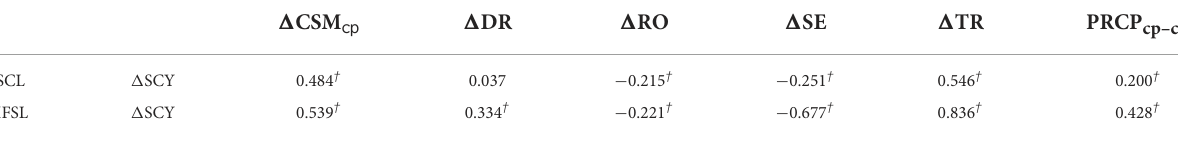
TABLE 3 Pearson correlations of PSCL and MFSL seed cotton yield effects ( 1 SCY) vs. column soil moisture effects at planting ( 1 CSM cp ), drainage ( 1 DR), runoff ( 1 RO), surface evaporation ( 1 SE), and transpiration ( 1 TR) effects during the cotton planting to harvest period, and total planting to harvest precipitation (PRCP cp − ch